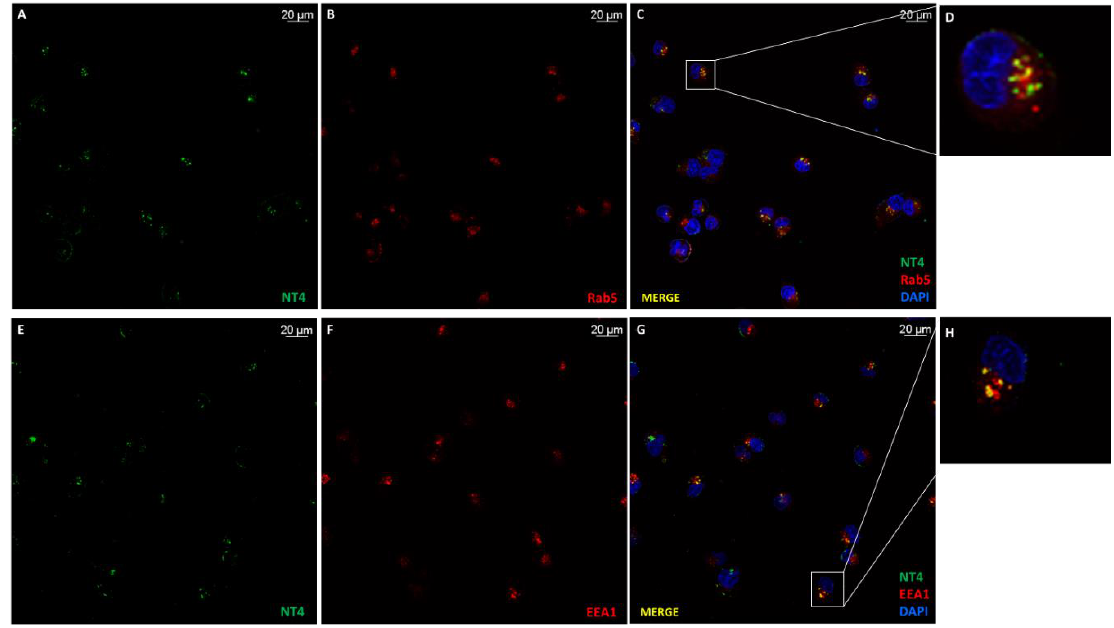
Figure 4. Co-immunostaining of NT4 with Rab5 and EEA1. ( A ) NT4 (green) and ( B ) Rab5 (red) colocalized ( C , D ); ( E ) NT4 and EEA1 ( F ) colocalized ( G , H ). Rab7 protein marks late endosomes. The subcellular location of NT4 and Rab7 was observed at two incubation times (15 and 60 min) with the peptide at 37 °C. As expected, colocalization increased in the time interval (Figure 5A,B): after 15 min, it was 19% ( n = 10, SD ± 4), with a Pearson coefficient of 0.33 ( n = 10, SD ± 0.03); after 1 h, the rate increased to 42% ( n = 10, SD ± 11), with a Pearson coefficient of 0.49 ( n = 10, SD ± 0.07) (Figure 5A,B). Rab11, a small GTPase associated with endosome-recycling vesicles, gave a colocalization rate of 24% ( n = 6; SD ± 5.89) and a low Pearson coefficient (0.38; n = 6, SD ± 0.039) (Figure 5C), indicating scarce presence in the recycling endosomes. Figure 5. NT4 colocalization with Rab7 and Rab11. ( A ) NT4 and Rab7 after 1 h incubation; ( B ) normalized values of colocalization rate and Pearson coefficient of NT4 and Rab7 after 15 min and 1 h incubation; ( C ) NT4 and Rab11 after 1 h incubation. 2.4. Effects of NT4 on Cancer Cell Migration The polycationic peptide NT4 has already been shown to interfere with cancer cell migration [34], impairing 2D and 3D migration of pancreas cancer cells and HUVEC endothelial cells and hampering invasive migration of MDA-MB-231 cells through collagen [18]. In a standard 2D